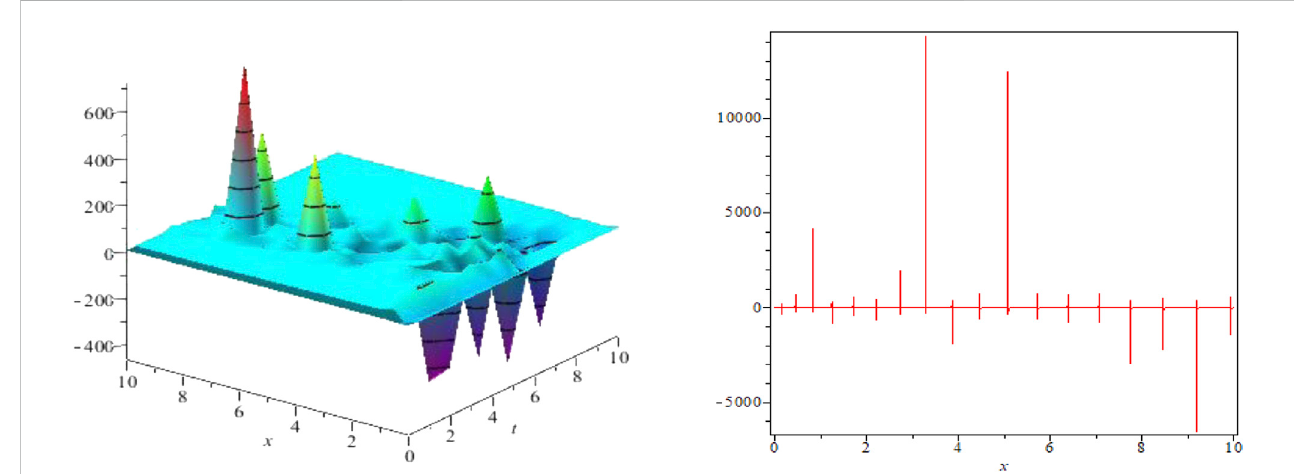
FIGURE 1 Periodic solution for Eq. 35 for Y 12 at ω (cid:2) 1